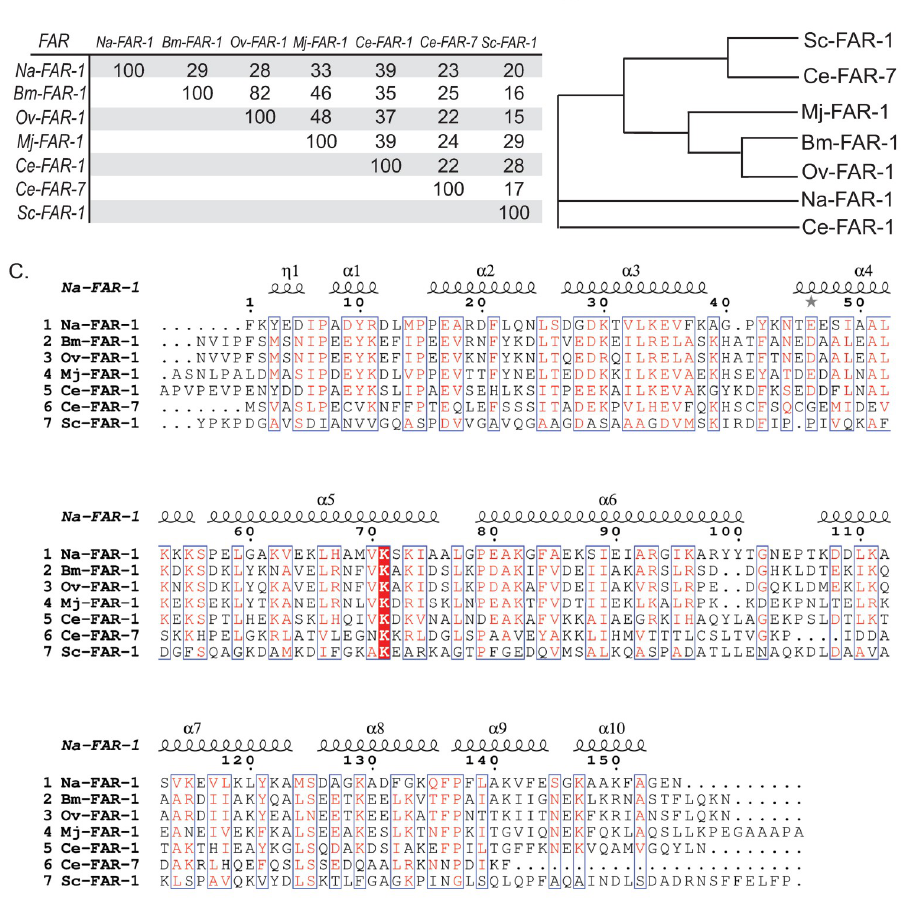
Fig 1. Comparison of FAR proteins across free-living and parasitic nematode species. (A) Table of percent identity among various FAR proteins showing Ov-FAR-1 with the highest similarity to Bm-FAR-1 (82 percent). (B) Phylogenetic tree of FAR sequences included in alignment created in ClustalW. (C) The FAR protein sequences are aligned with clustalW2 with secondary structures shown as an estimation based on the N . americanus Na -FAR-1 (4XCP) crystal structure using ESPript [23,51].Sequence identities are as follows: Na-FAR-1 (XP_013293708), Bm- FAR-1 (Q93142), Ov-FAR-1 (Q25619), Mj-FAR-1 (AFZ77091), Ce-FAR-1 (CAA79616), Ce-FAR-7 (NP_493708), and Sc-FAR-1 (TKR66991). The various secondary structures are labeled α with squiggles for large alpha helices and η with squiggles for 3 10 helices. Alternate residues are highlighted with gray stars. R AU : PleasecheckwhethertheeditstothesentenceResiduesthatareidenticalamong ::: ð Fig 1 caption Þ arecorrectandamendifnecessary : esidues that are identical among all groups are highlighted in red, and conserved residues are shown in red; both are outlined in blue. FAR, fatty acid–and retinol- binding